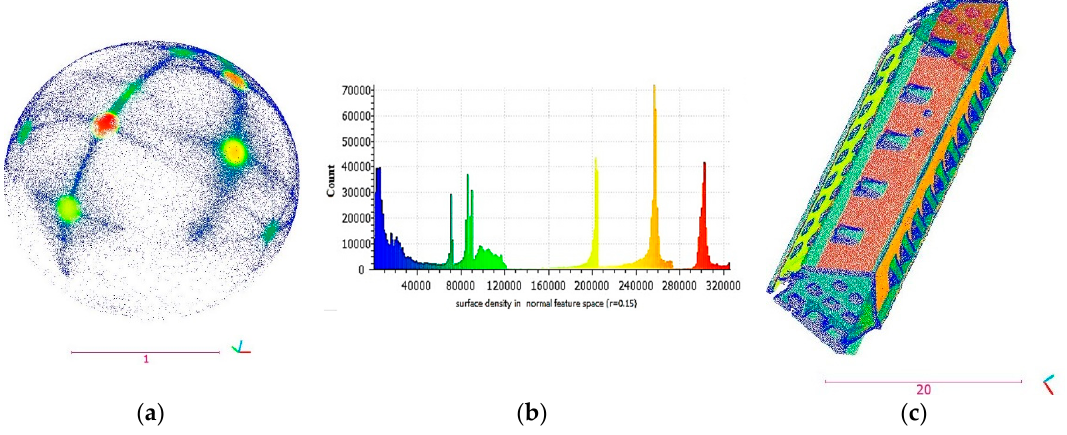
Figure 5. Basis of the proposed filter in the normal vector space. ( a )Directional cosines of normal vectors on the unit sphere. ( b ) Surface density of local normal vectors. ( c ) The labelled point cloud of the building (in m).